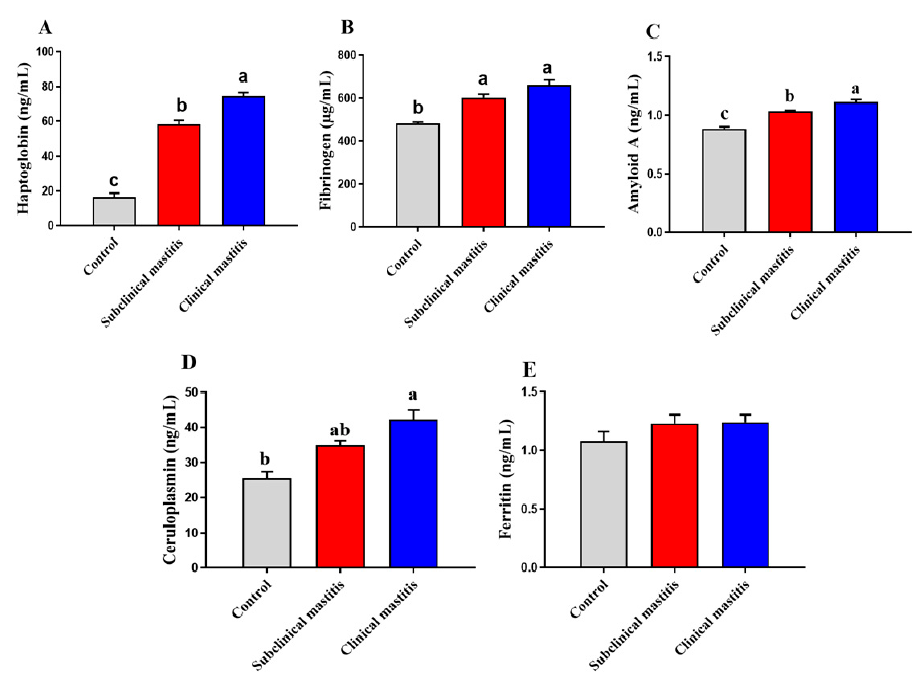
Figure 1. Serum Acute phase protein of dairy cows with subclinical and clinical mastitis. Data were represented as Mean ± SME. This means in with different superscripts are significantly different ( p < 0.05). a significantly different from b and c, a for the high value, b for intermediate value between a and c, while c for the lower value. Haptoglobin ( A ), fibrinogen ( B ), Amyloid A ( C ), ceruloplasmin ( D ), and ferritin ( E ).